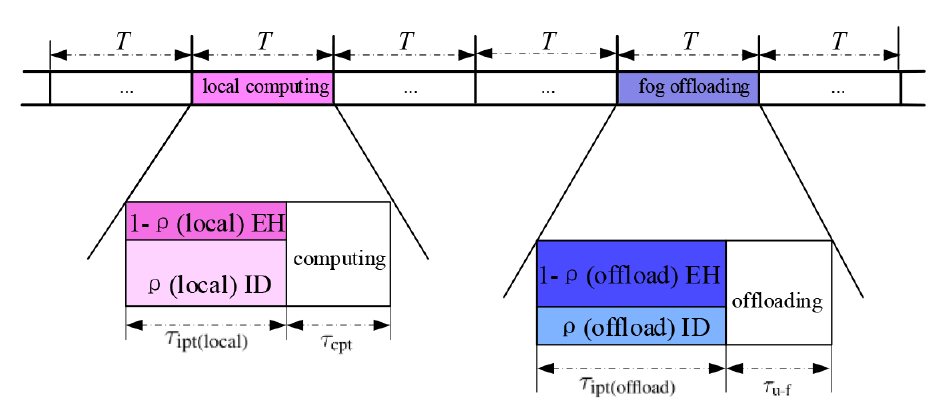
Figure 2. Illustration of the time frame